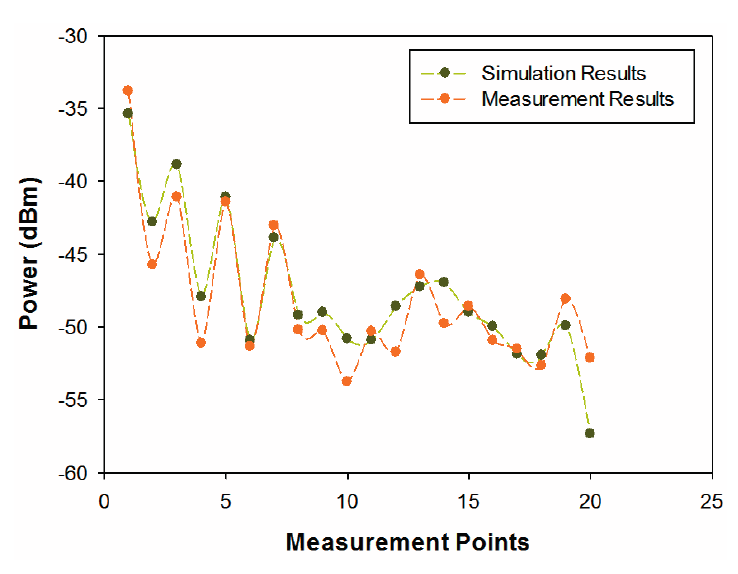
Figure 17. Comparison of simulation vs.